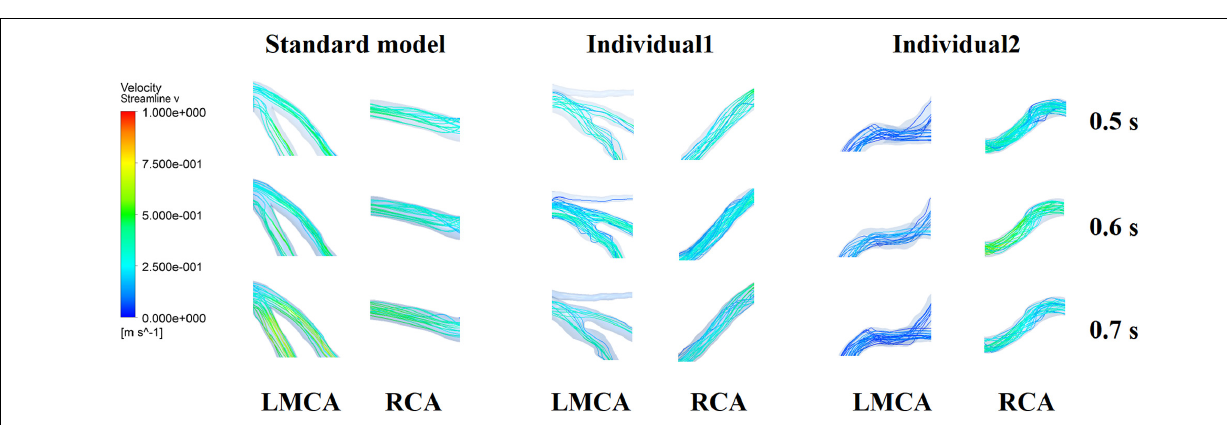
FIGURE 12 | Flow velocity streamlines at the inlet of RCA and LMCA of three models under the different pressurization